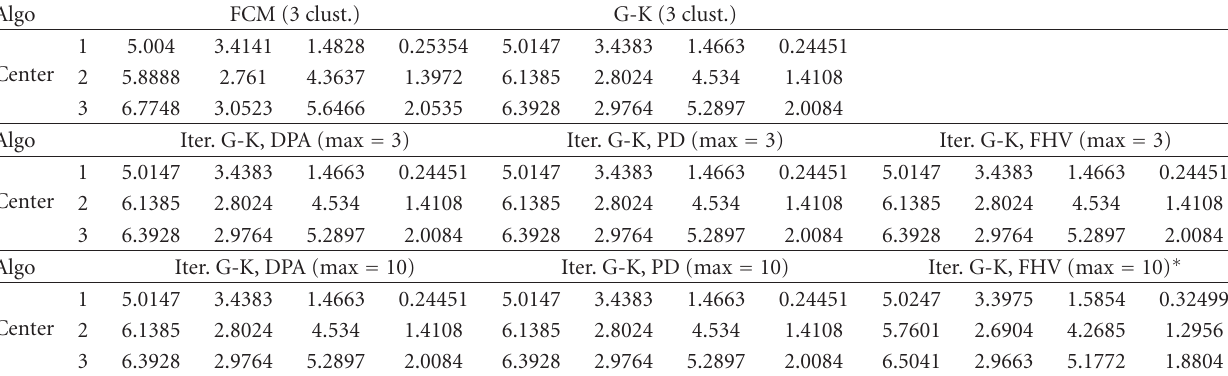
Table 3: Iris cluster centers reported by various algorithms and settings. ∗ Cluster centers obtained from clustering of 9 resultant subclusters using FHV, max =